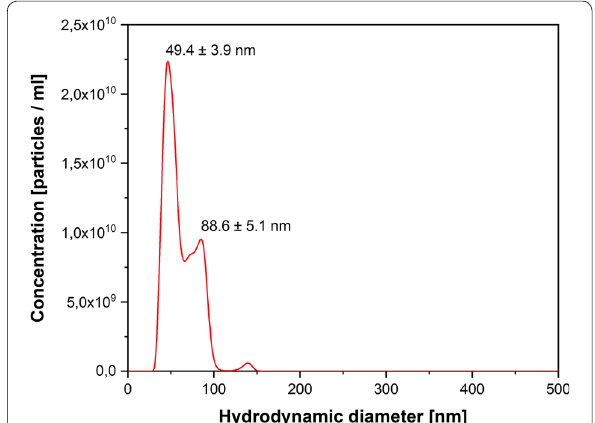
Fig. 4 Hydrodynamic diameter of green synthesized Ag NPs by